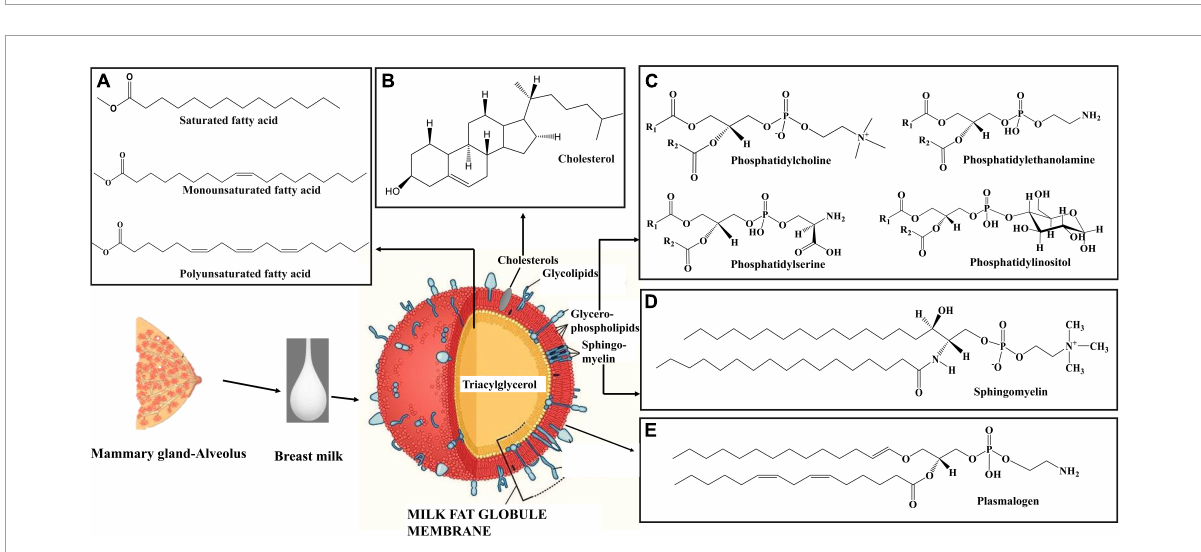
FIGURE3 Schematic diagram of milk fat globule (108). (A) Structure of different types of fatty acids in breast milk triacylglycerol. (B) Structure of cholesterol in breast milk. (C) Structure of phospholipid classes in breast milk. (D) Structure of sphingomyelin in breast milk. (E) Structure of plasmalogen in breast milk. The milk fat globule membrane structure was modified from Mead Johnson Nutrition (108). Structures were created using Chem Draw